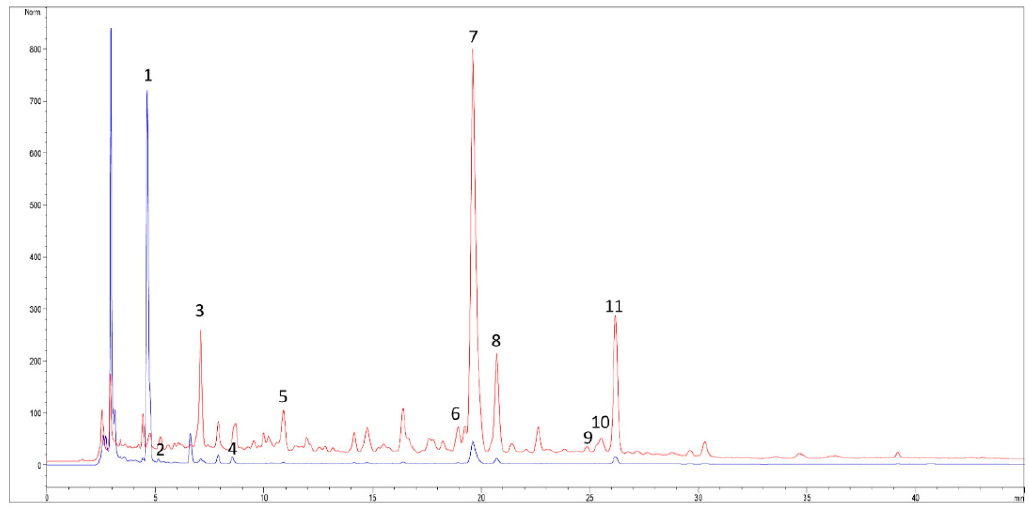
Figure 1. HPLC-DAD profile of Opuntia ficus indica cladodes (OFI) at two wavelengths: 280 nm (blue trace) and 325 nm (red trace). Polyphenol identification: 1 = piscidic acid I; 2 = piscidic acid II; 3 = ferulic acid derivative I; 4 = eucomic acid; 5 = ferulic acid derivative II; 6 = kaempferol derivative I; 7 = isorhamnetin derivative I; 8 = isorhamnetin derivative II; 9 = kaempferol derivative II; 10 = isorhamnetin derivative III; 11 = isorhamnetin 3-O-rutinoside (narcissin).